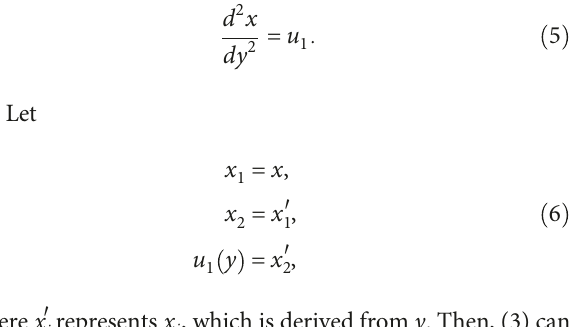
Figure 2: Two-dimensional curve design